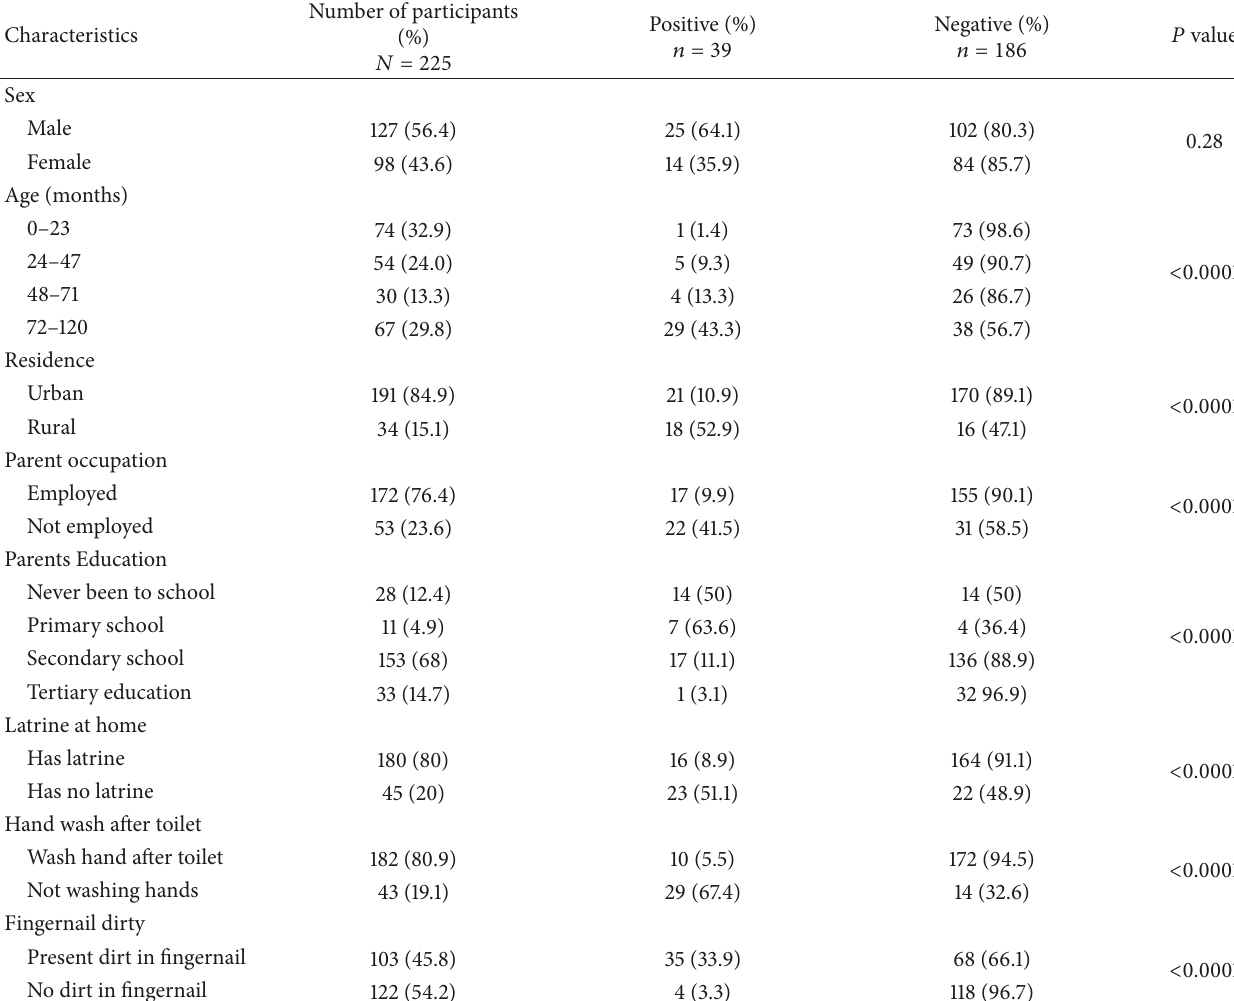
Table 1: Demographic characteristics and overall prevalence of intestinal helminth infestation in children.